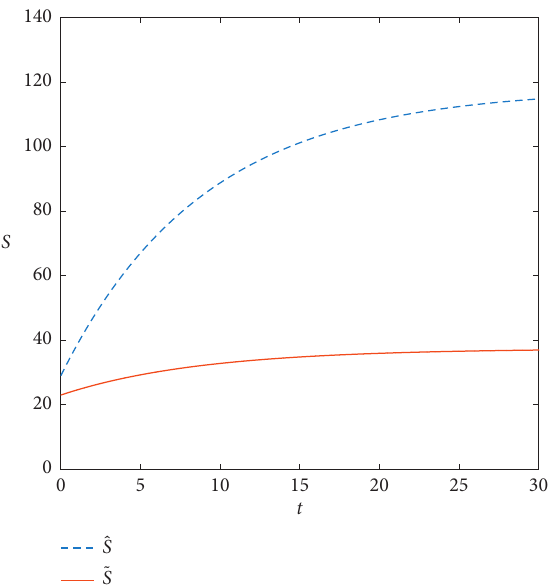
Figure 15: The pollution stock trajectory of the downstream region under cooperation.